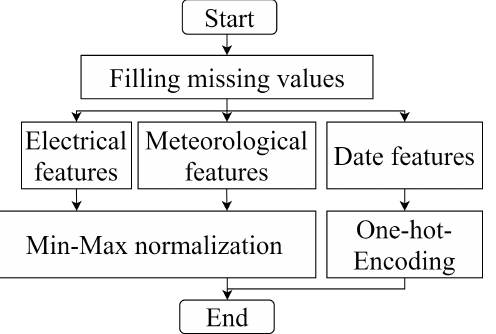
Figure 5. Flowchart of the adopted data prepossessing